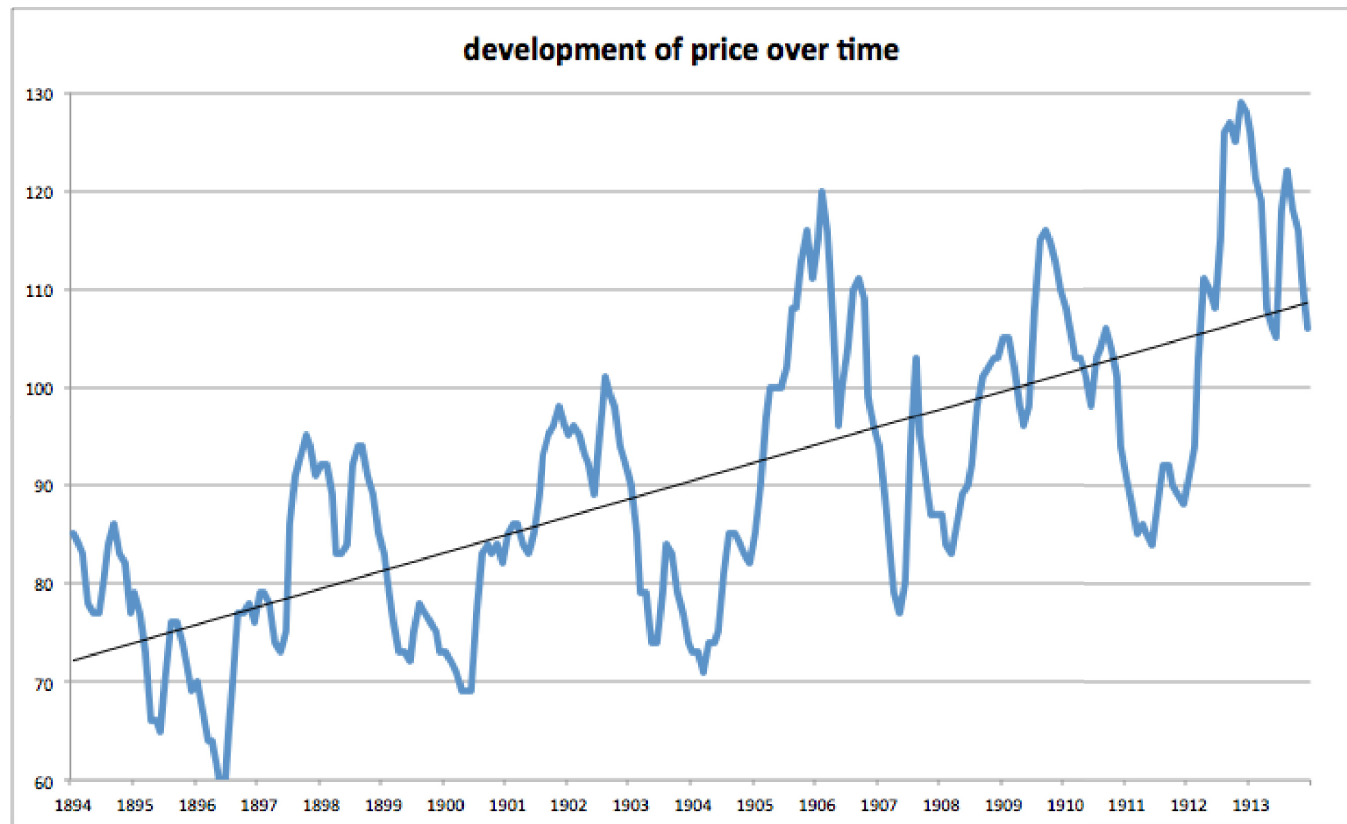
Fig 1. Hog Cycle That Started the Literature ([2]: 10). English translation of German original: Hog Prices in Berlin July 1896 to June 1914 (Pigs with Live Weight 80 – 100 kg) in Mark [German currency of the time] per 100 kg live weight.